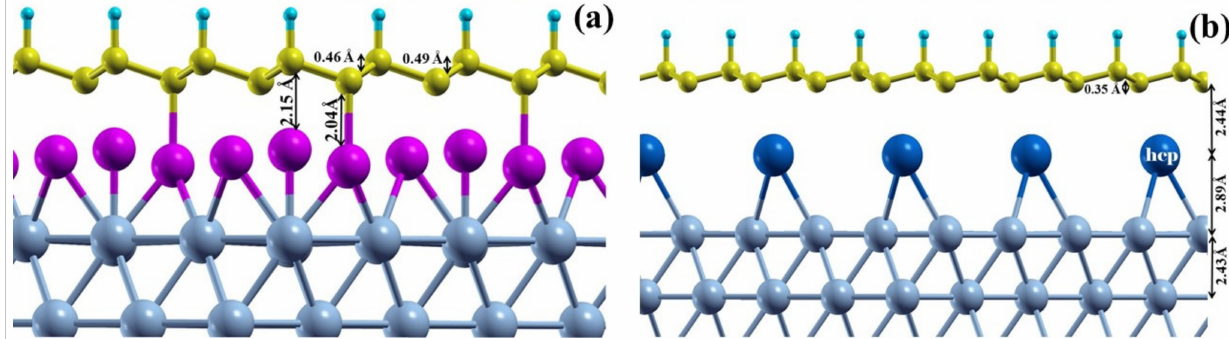
Figure 5. ( a ) Side view of Ni(111)/Al/GrH, ( b ) side view of Ni(111)/Na/GrH, where the atoms in cyan denote